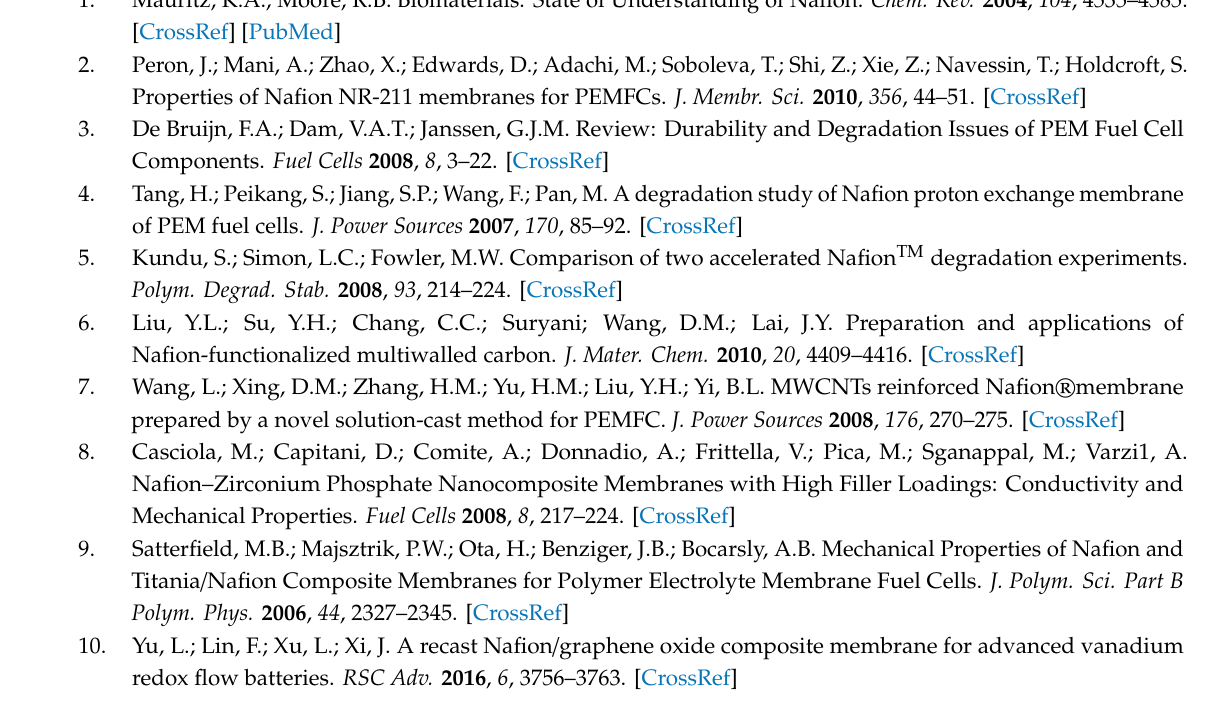
Figure S1: (a) Water uptake and (b) swelling ratio of recast Nafion and its composites with GO, SGO, and SGO / ceria in varying filler